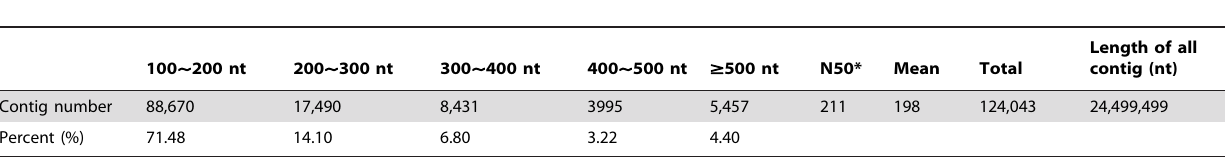
Table 1. The contigs assemble results of O. furnacalis transcriptome.